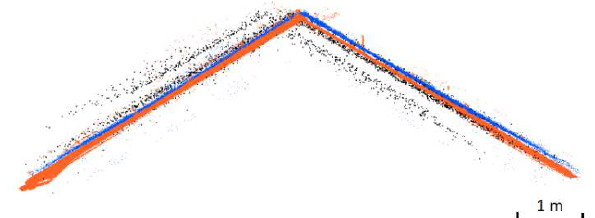
Figure 5 . Profile of point clouds for roof planes: ULS (black), DIM (blue) and TLS